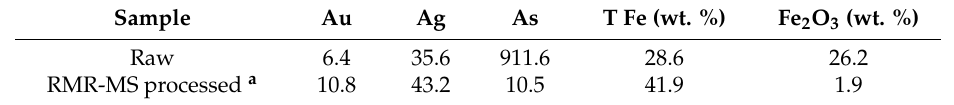
Table 3. Composition of Au, Ag, As, Fe and hematite (Fe 2 O 3 ) in the raw ore sample and RMR-MS processed samples.